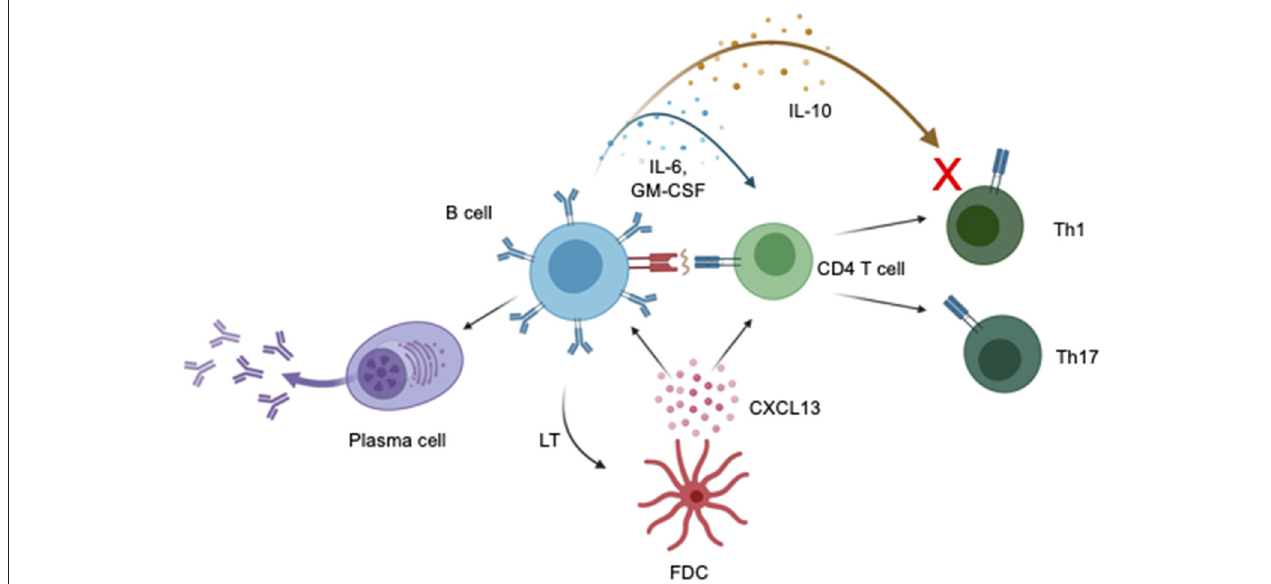
FIGURE 1 | Impact of B cells on PPMS pathogenesis. Production of cytokines influences the function of CD4 T cells, including promoting and suppressing inflammation. Production of the cytokines IL-6 and GM-CSF can induce differentiation of CD4 T cells into Th1 and Th17 T cells which can then cause CNS damage. The cytokine IL-10 is believed to decrease activity of Th1 effector T cells and reduce neuroinflammation in EAE and MS. Decreased IL-10 production by B cells may result in increased neuroinflammation in MS. B cells induce T cell activation and differentiation into pro-inflammatory T cell subsets via antigen presentation via the tri-molecular complex of MHCII, antigen, and T cell receptor. B cells are capable of differentiating into antibody secreting cells which produce antibodies capable of directly damaging the CNS. Binding of lymphotoxin (LT) by follicular dendritic cells induces secretion of CXCL13 which may serve as a chemoattractant for B cells and T cells, increasing lymphocyte infiltration into the CNS. Created with